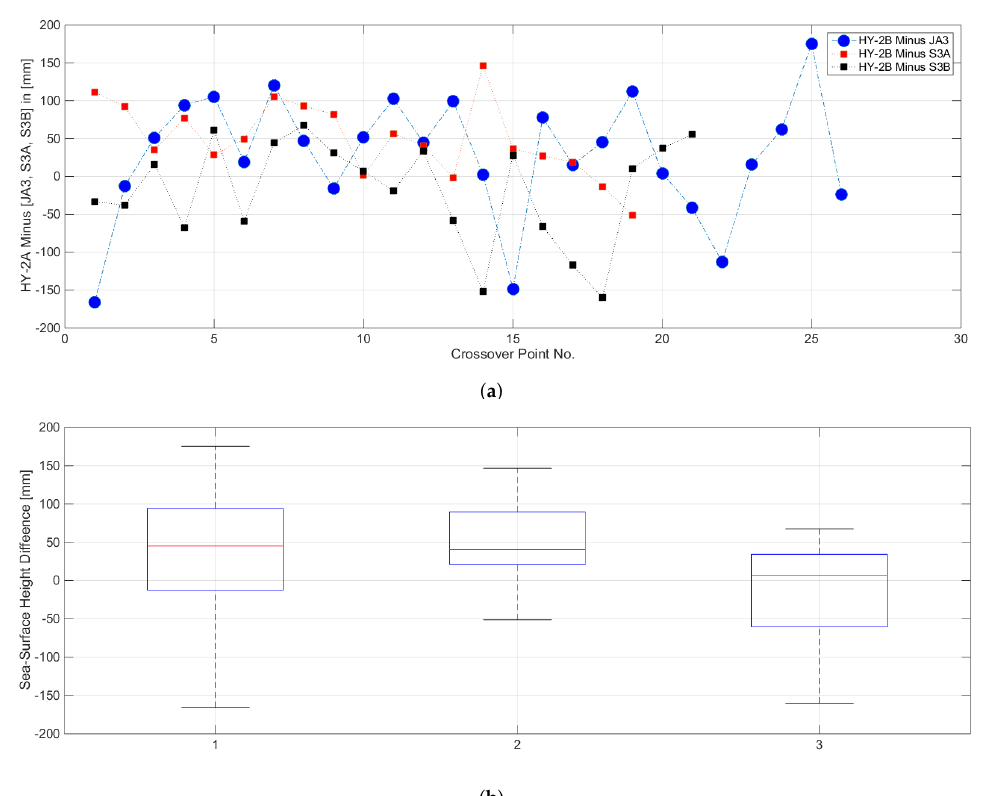
Figure 16. Sea-surface height observations made by HY-2B at crossover locations around Crete and against other satellite altimeters such as Jason-3, Sentinel-3A and Sentinel-3B. Crossover locations are shown in Figure 9. ( a ) Dispersion of differences of sea-surface heights measured by HY-2B minus Jason-3, S3A and S3B. ( b ) Boxplots of the differences: (1) [HY2B-Jason-3], (2) [HY2B-S3A] and (3)